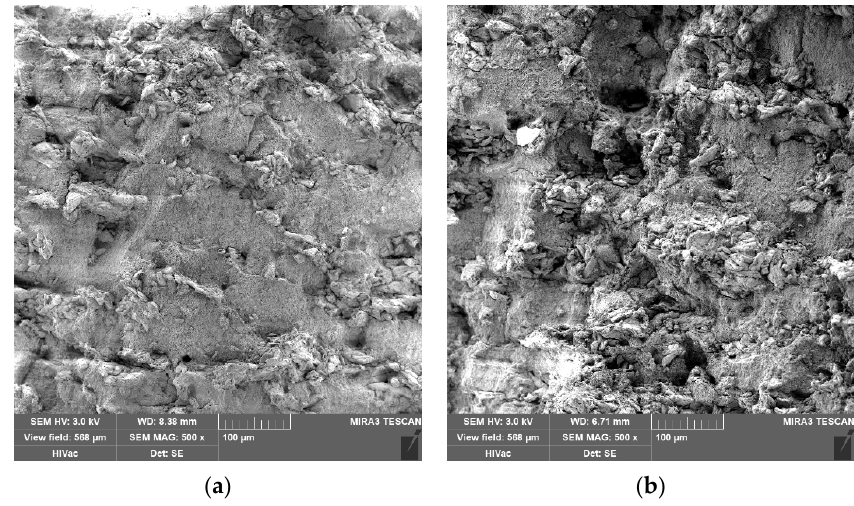
Figure 3. Images of Blank_W_HA_180 min ( a ) and Blank_W_MW_3 min ( b ).